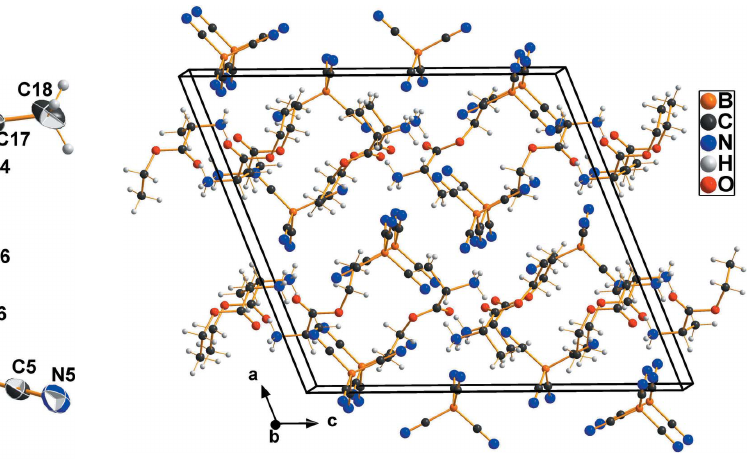
Figure 1 The asymmetric unit of (C 5 H 12 NO)[B(CN) 4 ] with atom